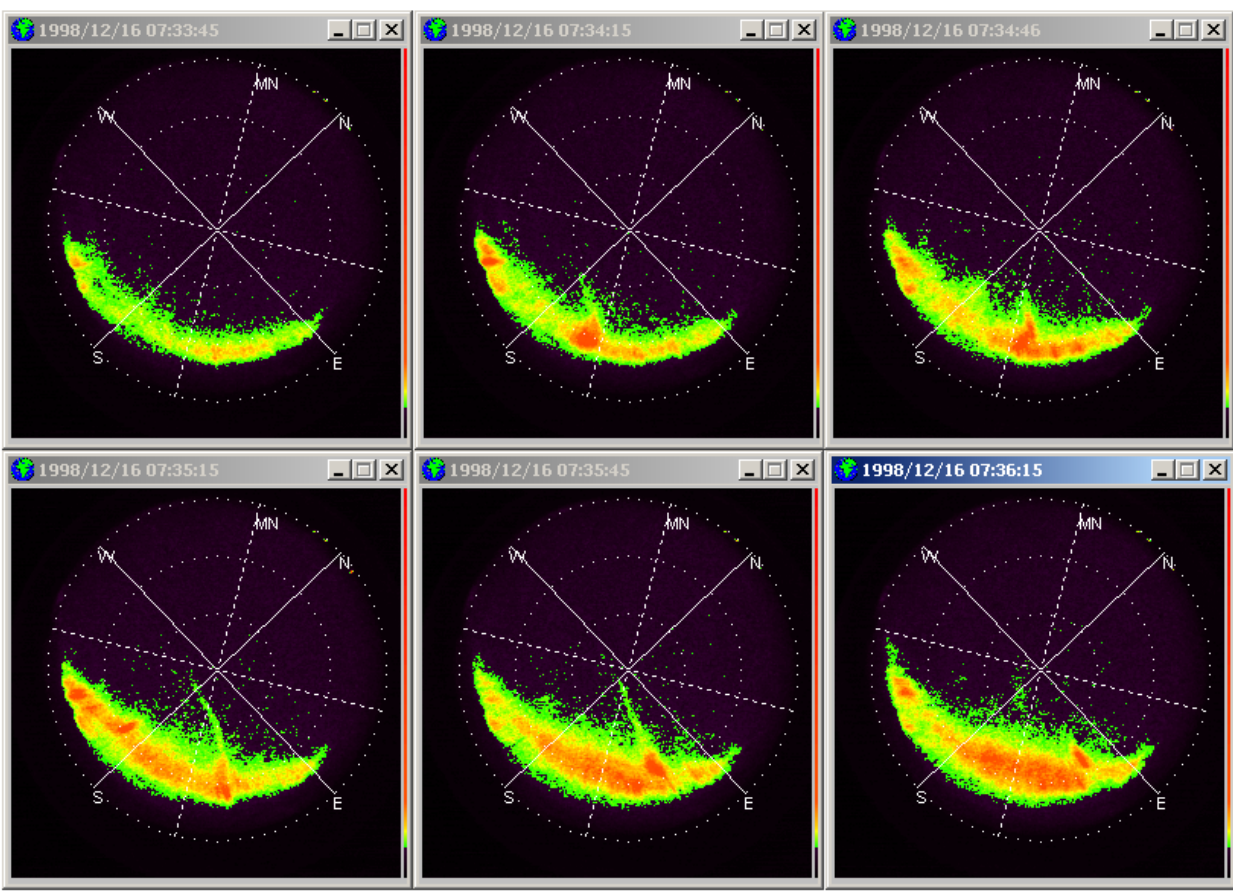
Fig. 3. All-sky auroral images at 557.7 nm taken at Ny Ålesund at the times 0733:45, 0734:15, 0743:46, 0735:15, 0735:45, and 0736:15 UT. The reference system is zenith angle (dashed circles representing 30 ◦ , 60 ◦ , and 90 ◦ ) and azimuth angle. The magnetic meridian through Ny Ålesund is marked by dashed line